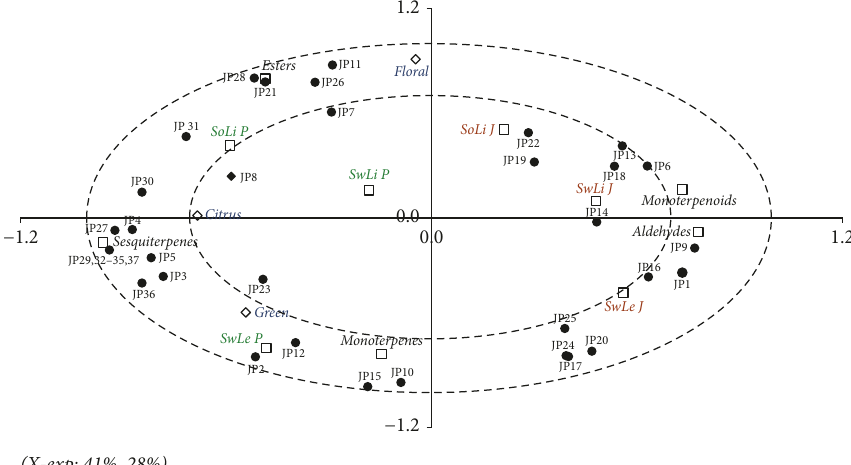
Figure 3: PCA map showing the relationships among volatile compounds, chemical families, and sensory attributes of endangered Spanish lime and lemon